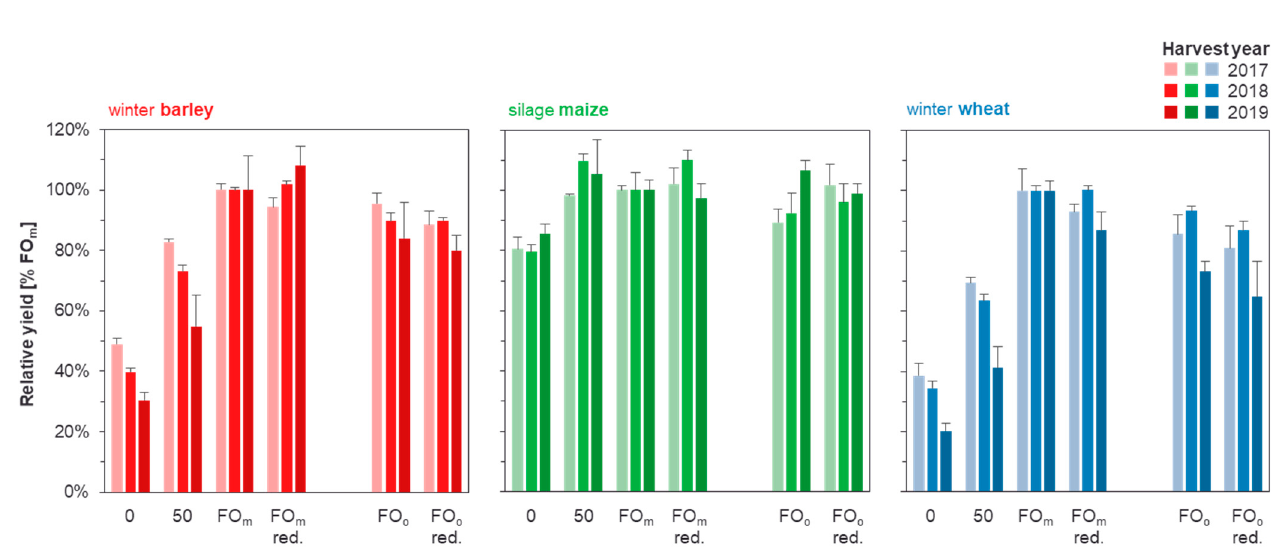
Figure 2. Mean relative yield compared to FO m treatment (grain yield at 86% dry matter for cereals and total biomass dry matter yield for silage maize) (N = 3, error bars indicating 1 standard error of the mean).